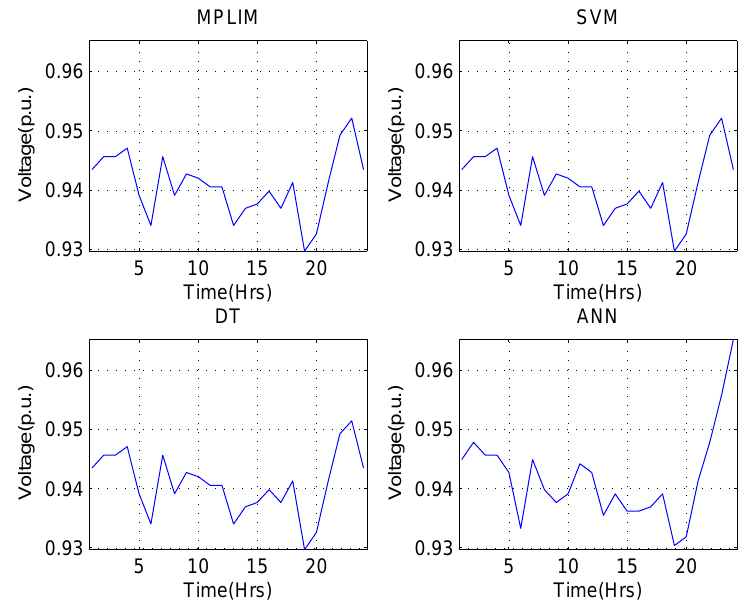
Figure 8. Minimum voltage calculated for 24 h. Day 2 was chosen to validate the results from this database, which is the day with the highest levels of energy losses. Table 6 shows a comparison of the hourly values of energy losses of the studied system, obtained by MPLIM and by the three ISs for the day that present higher levels of losses.